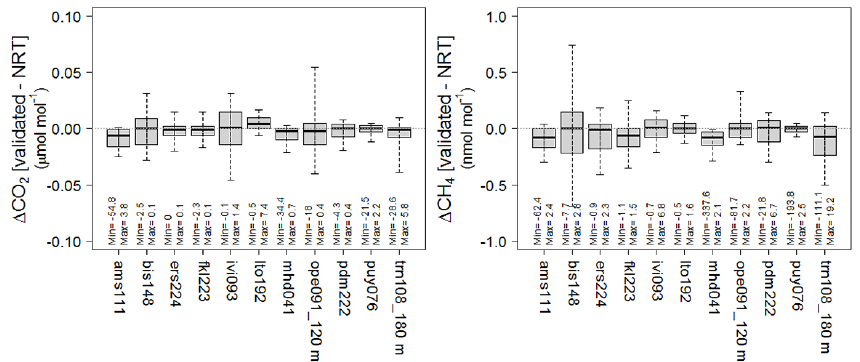
Figure 11. Statistics of the validated minus NRT differences of hourly means CO 2 (left) and CH 4 (right) mole fractions. Each of the 11 box-and-whisker plots describes the differences for monitoring stations in 2014. The length of the box represents the interquartile range, the horizontal line represents the median and the low and high whiskers show the first and ninth deciles, respectively. The numbers below the box plots give the maximum and minimum